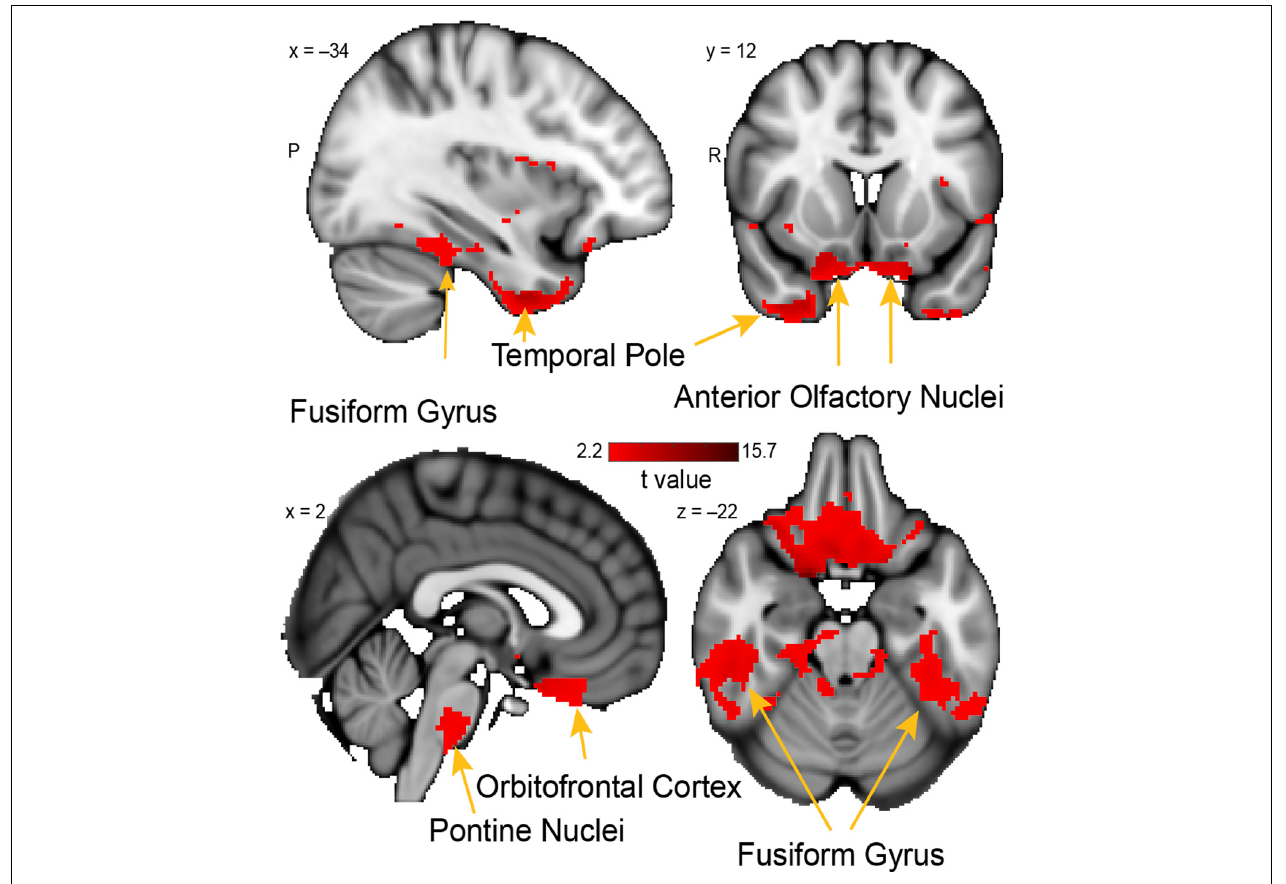
FIGURE 6 | Whole-brain resting connectivity of the PAC. Regions of interest include the fusiform gyrus, anterior olfactory nucleus, pontine nucleus, and orbitofrontal cortex. The connectivity map was thresholded at threshold-free cluster enhancement corrected P < 0.05. Results are overlaid on FSL’s MNI152_T1_1 mm_brain.